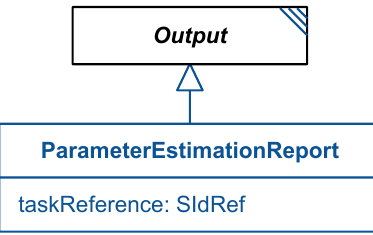
Figure 2.25: The definition of the SED-ML ParameterEstimationReport